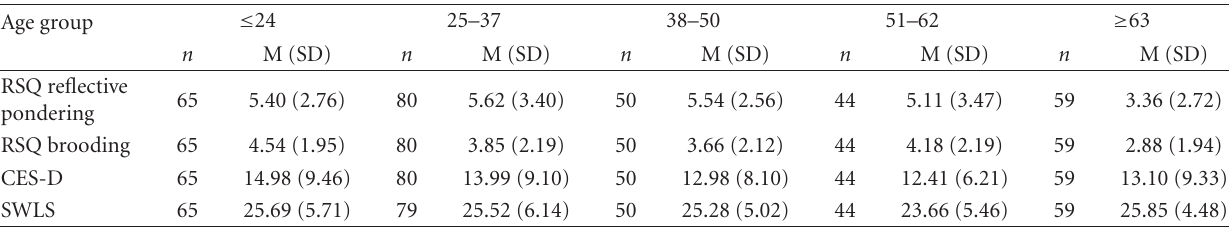
Table 4: Self-report measures by age